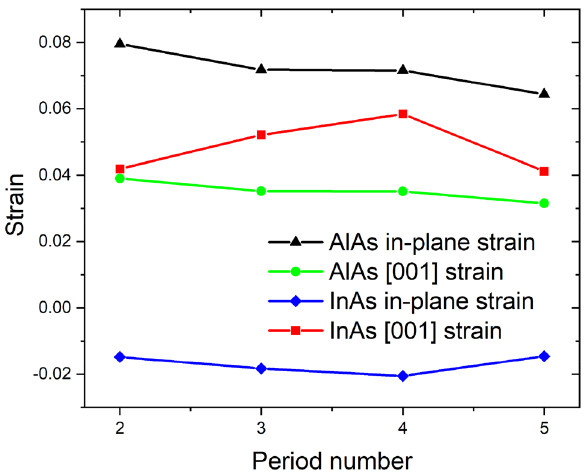
Figure 4. The calculated in-plane strain and the strain along the [001] growth direction for both InAs and AlAs layers in the (InAs) n /(AlAs) n SPSs grown with different